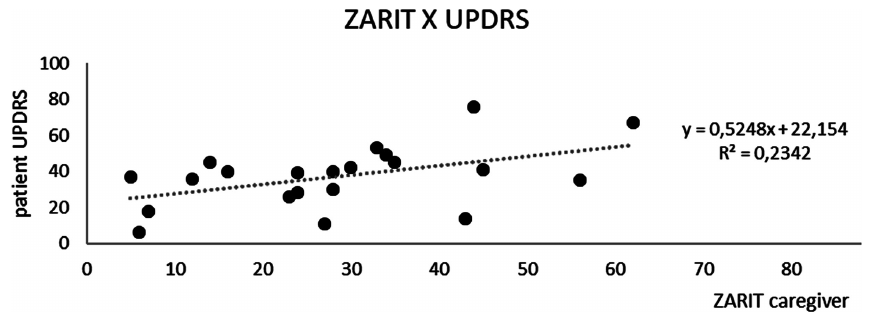
Figure 2. Scatter plot: ZBI (caregiver Zarit) and UPDRS patient scores with linear regression analysis and trendline plus R 2